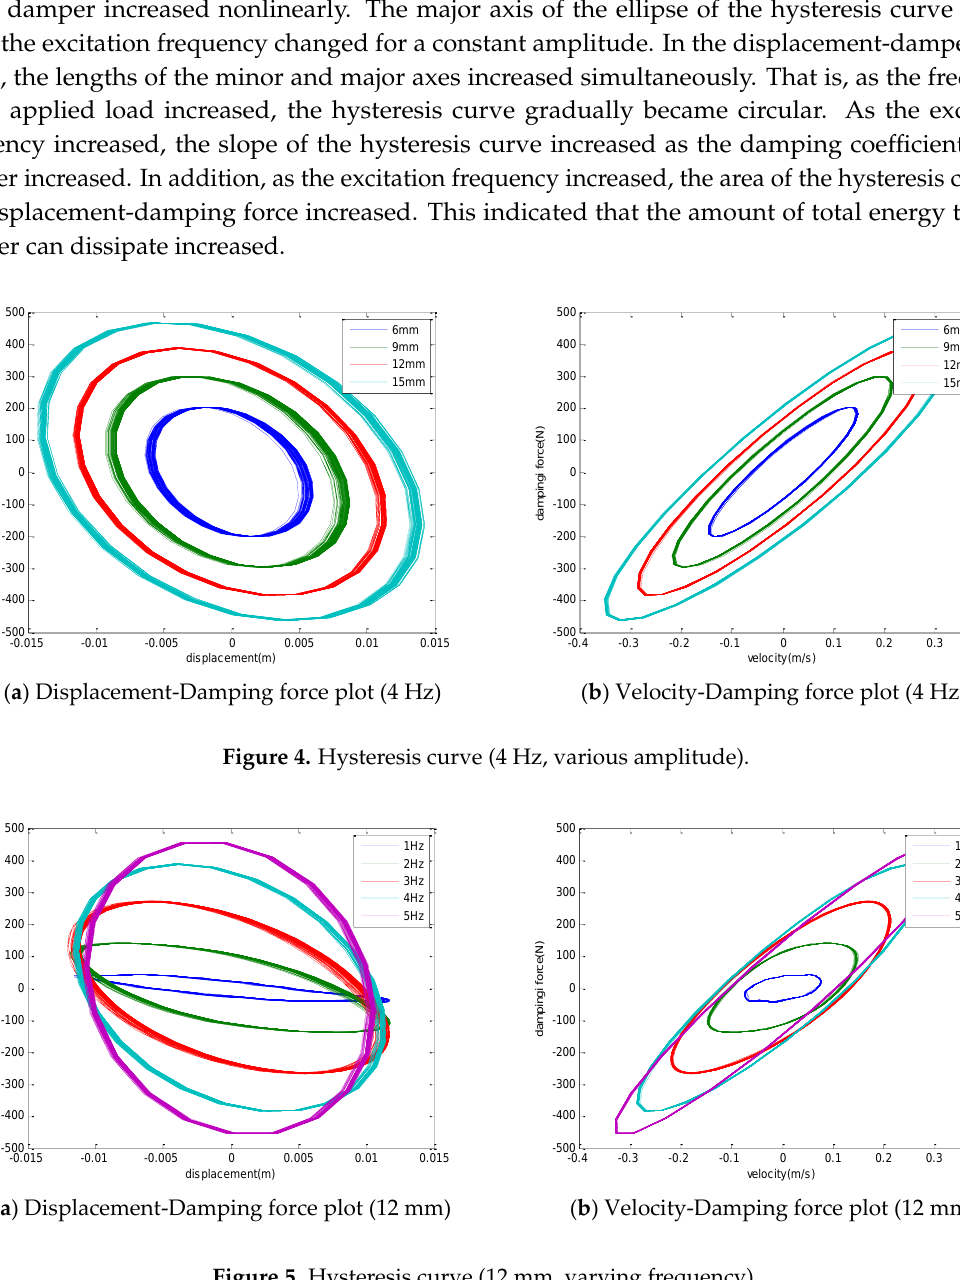
Figure 5. Hysteresis curve (12 mm, varying frequency).